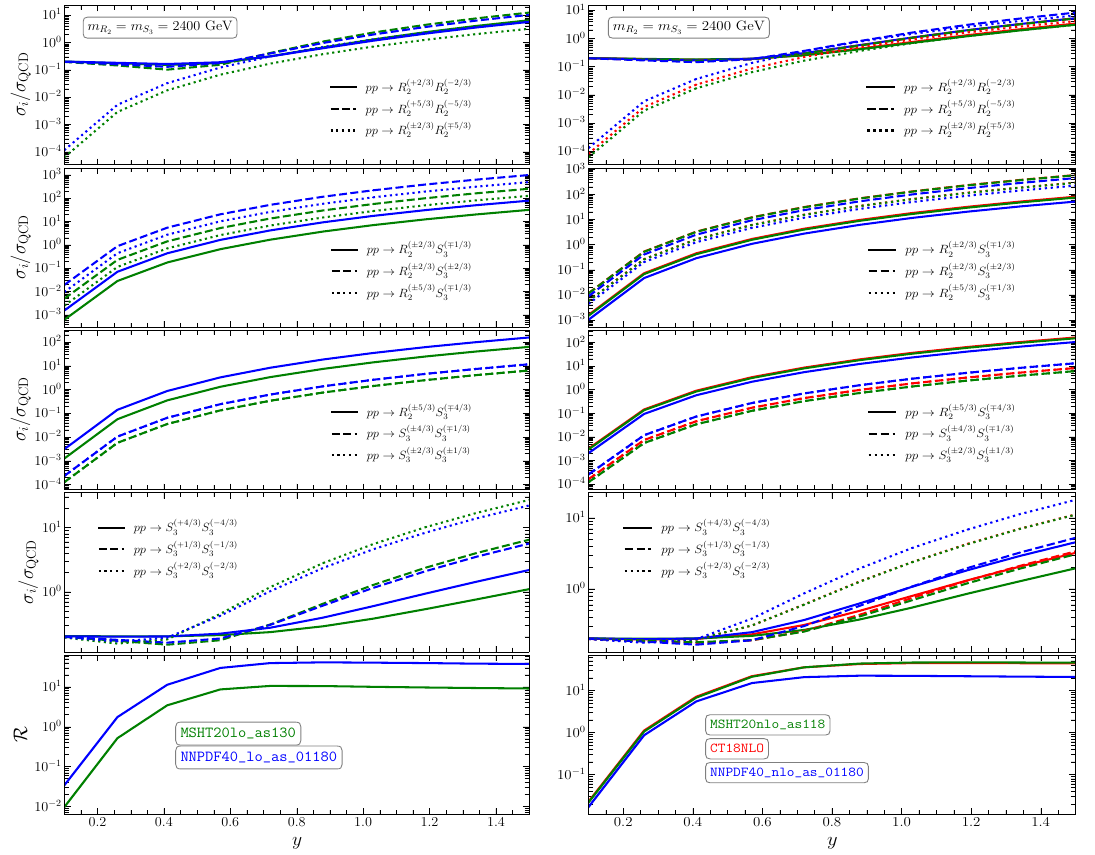
Figure 14 . Same as in figure 7 but for m R